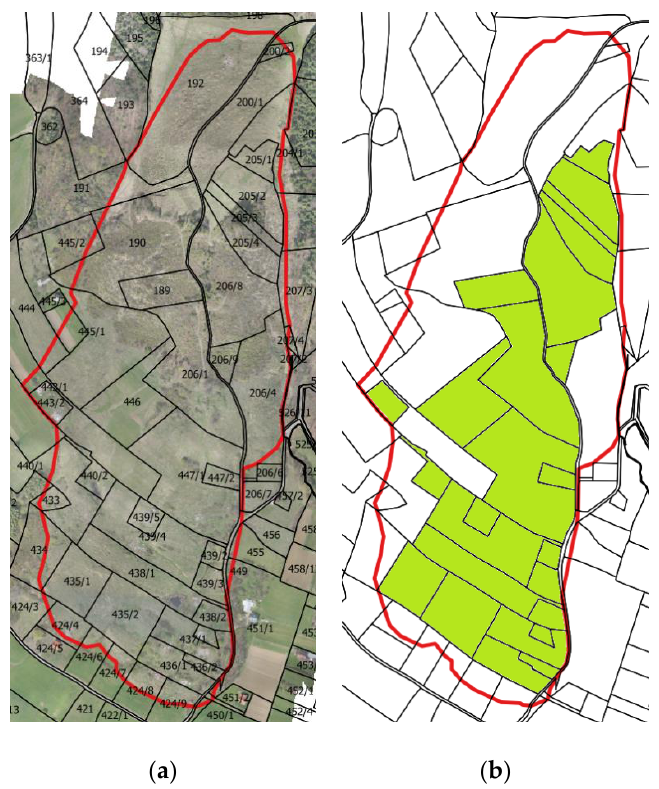
Figure 7. ( a ) Outline of the landslide over plots of land; ( b ) plots wholly covered by the landslide. For the plots which were entirely covered by the landslide, data should be changed with respect